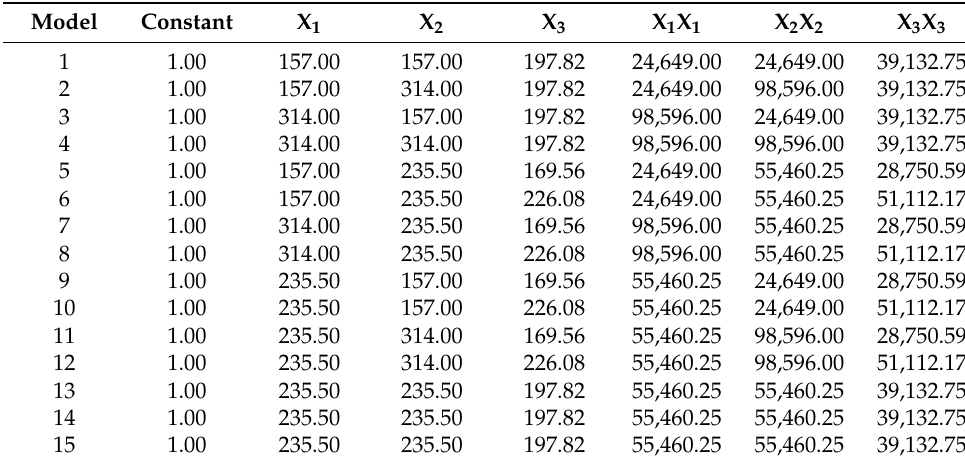
Table 7. Design matrix—linear and quadratic terms.